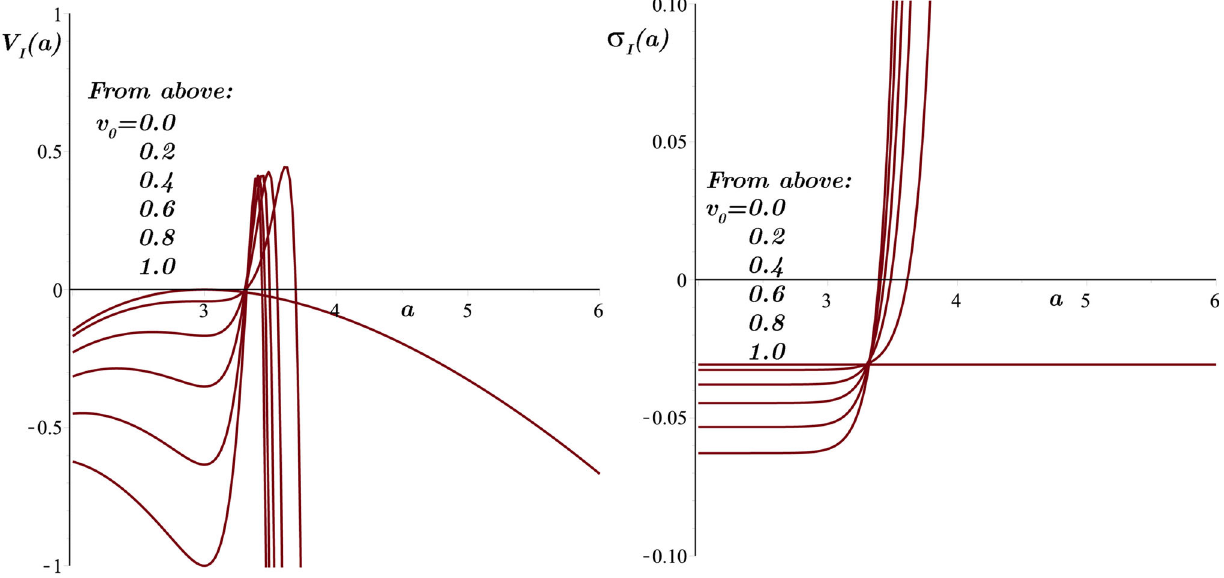
= − 16, M = 1 is the radius where the STSW is unstable irrespective of the value of 0 . The effect of v (cid:2)= 0 can be seen in the shape of the β 2 0 0